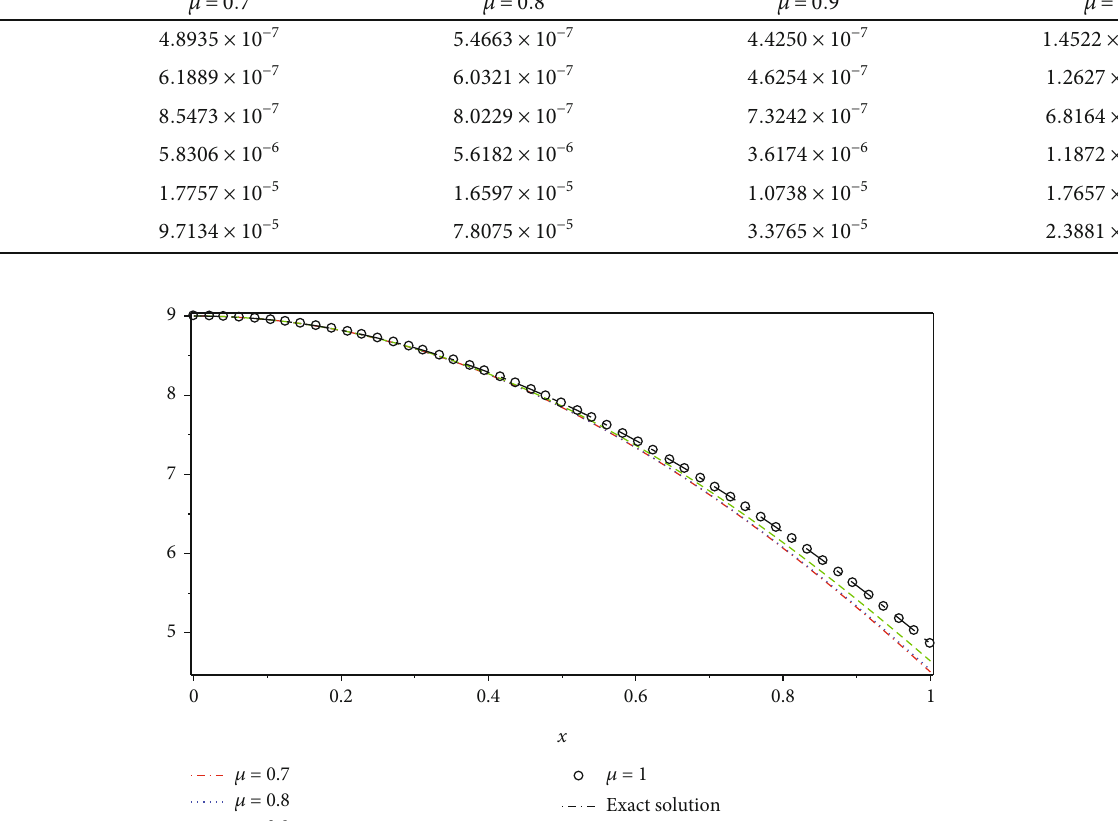
= k = 1, M = M = 4 at equally spaced points for Example 1. 1 2 1 2